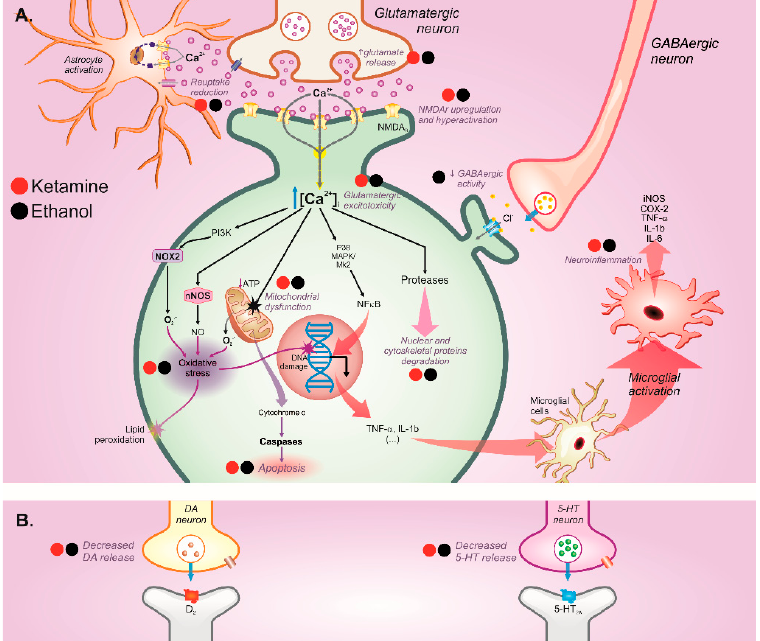
Figure 3. Principal repercussions of ketamine (red markers) or ethanol (black markers) withdrawal on ( A ) glutamatergic, GABAergic, ( B ) dopaminergic, and serotoninergic neurotransmission on the central nervous system. ( ) Damage or disruption.